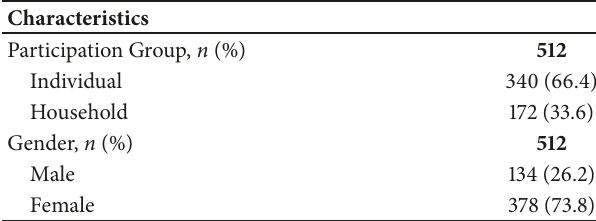
Table 1: Demographic characteristics of the CHIP study partici-